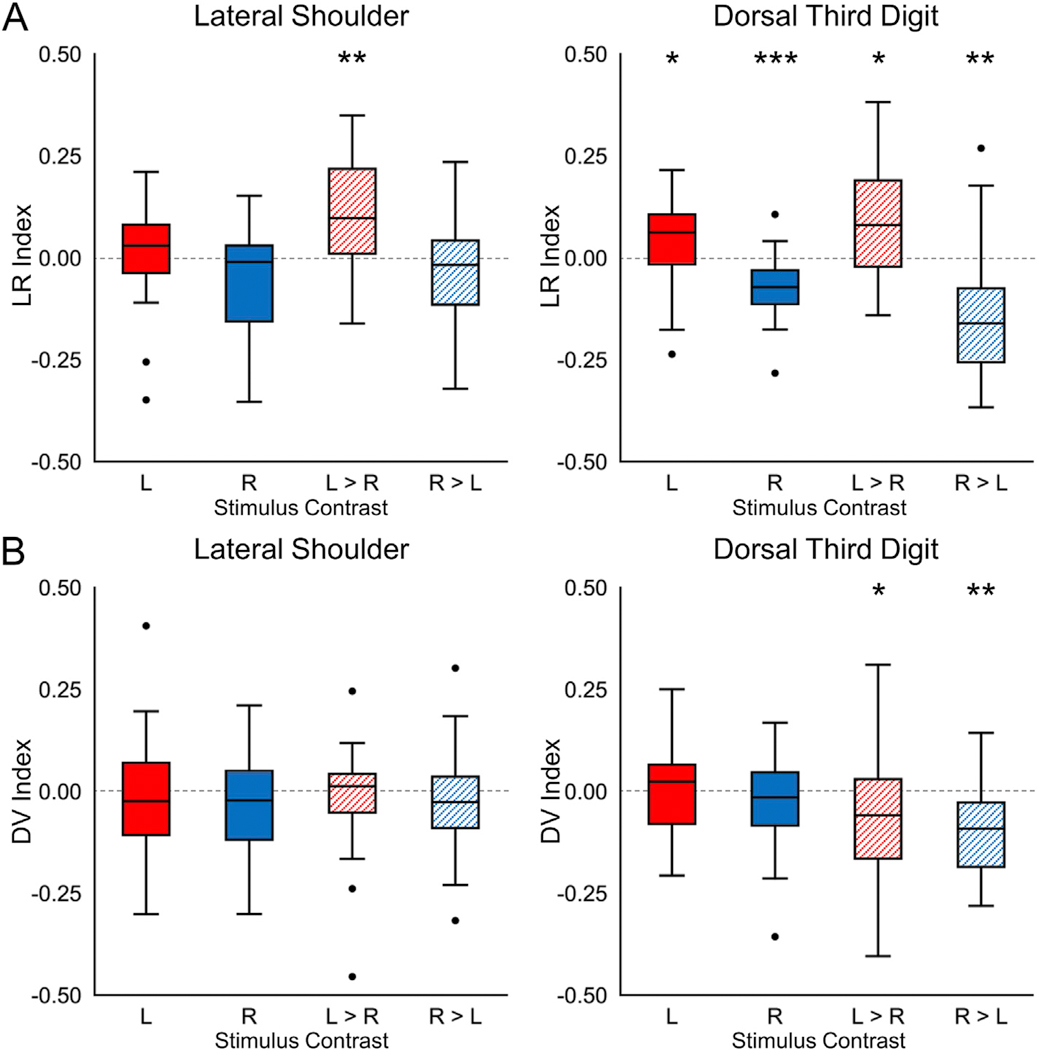
Box plots showing the location of the subject level activity for the lateral shoulder and dorsal third digit stimulation. A) The localization of the subject level activity to the left (L) and right (R) hemicords was summarized using the left-right (LR) index. For the LR index, a value of +1.0 indicates that all active voxels were in the left hemicord while a value of −1.0 indicates that all active voxels were in the right hemicord. B) Similarly, the localization of the subject level activity to the dorsal and ventral hemicords was summarized using the dorsal-ventral (DV) index. For the DV index, a value of +1.0 indicates that all active voxels were in the dorsal hemicord while a value of −1.0 indicates that all active voxels were in the ventral hemicord. The LR and DV indices are shown for each stimulation contrast. Subject level activity was defined using a voxel-wise threshold of Z-score > 2.3 with no correction for multiple comparisons. *p < 0.05, **p < 0.01, ***p < 0.001.